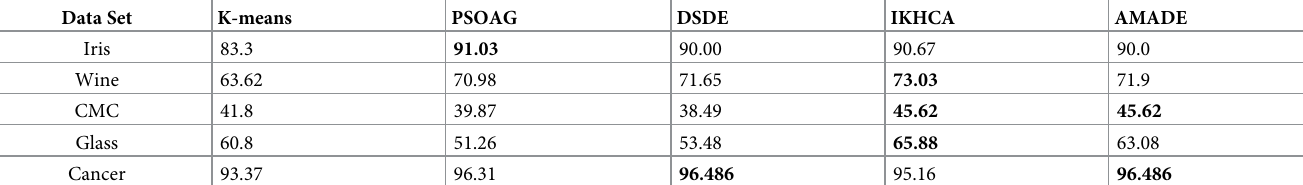
Glass 60.8 Cancer